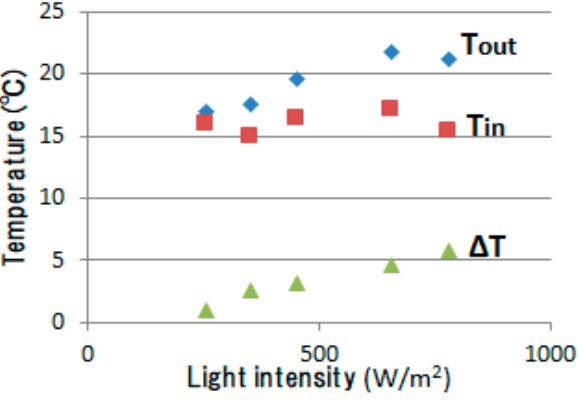
Figure 11. Velocity of generated wind in OPV-solar chimney at light intensity of 655 W/m 2 as a function of pitch angle. Figure 12 shows temperature profiles in the chimney as a function of time. The highest temperature was observed for channel 3, which was at the top surface of the irradiated area. The temperature showed saturation after 12 min from the outset. Most temperature profiles of the top surface behaved in the same manner while the temperatures at the bottom rose more slowly. This temperature difference may cause air flow in the chimney due to migration of uplifting warm air.